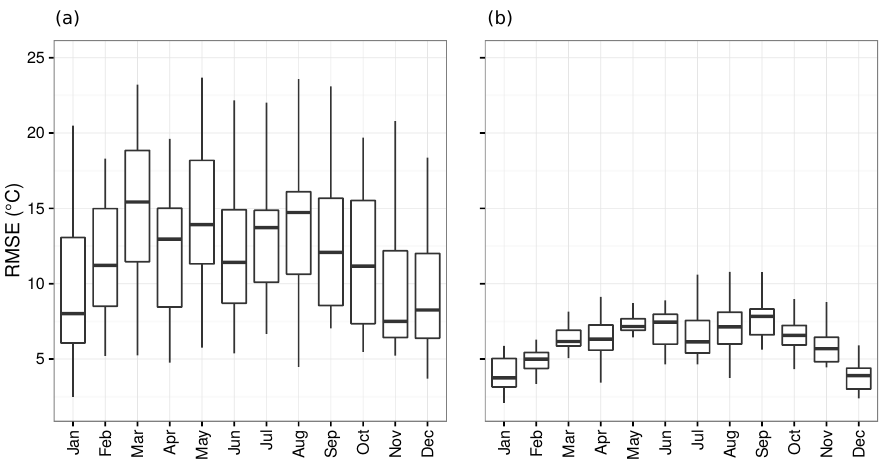
Figure 7. Monthly RMSE of T air predictions separately for ( a ) weather stations located on ice and ( b ) weather stations located on ice-free areas.